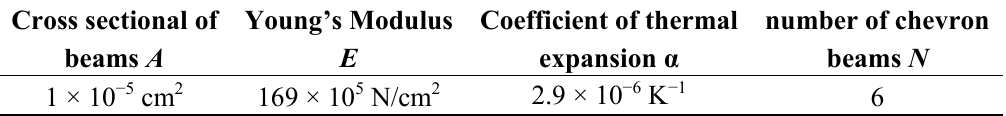
Table 3. Material properties of silicon in the chevron beams.